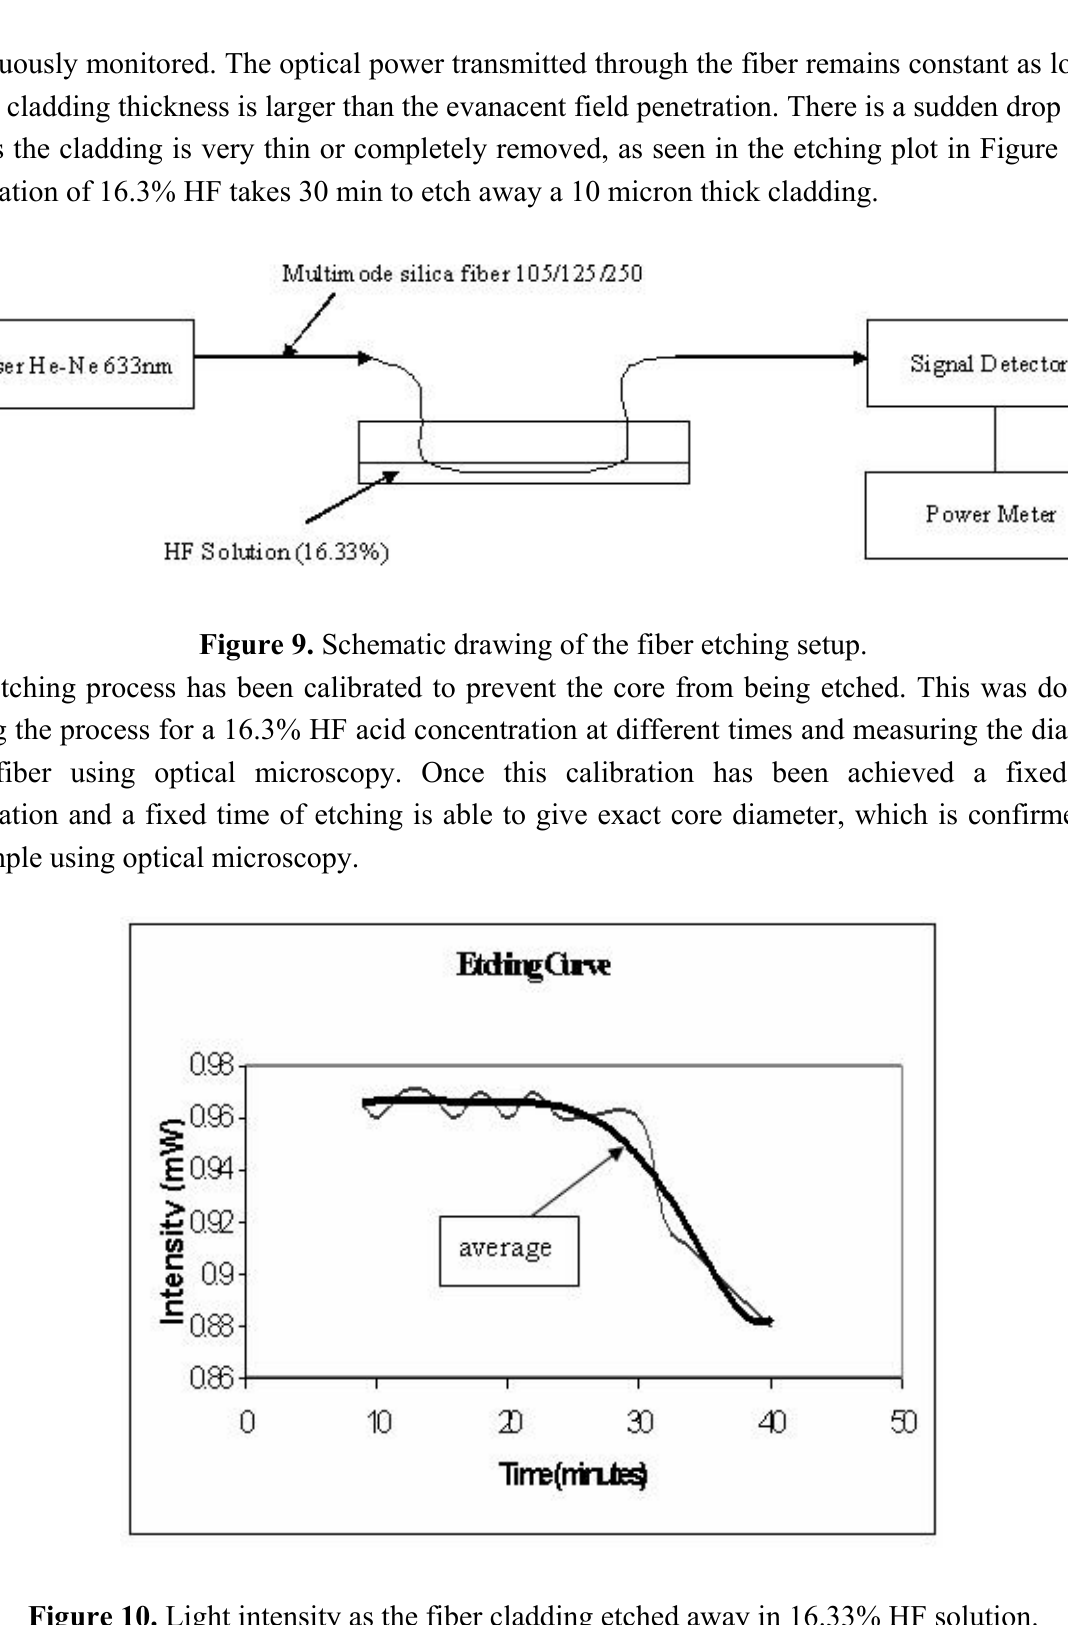
Figure 10. Light intensity as the fiber cladding etched away in 16.33% HF